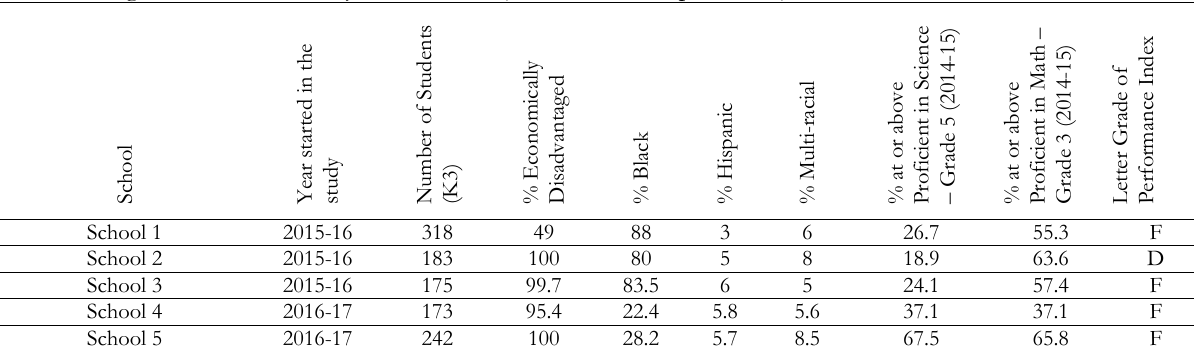
Table 1. High Needs Elementary School Sites (Ohio School Report Card)